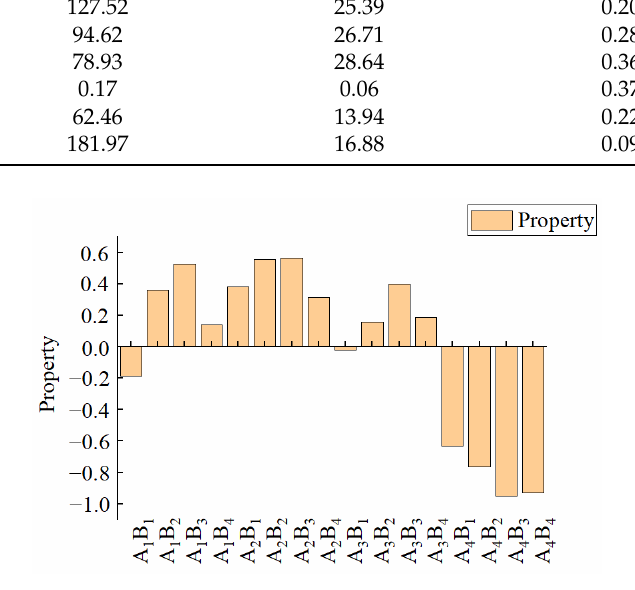
Figure 8. Comprehensive score for different treatments.